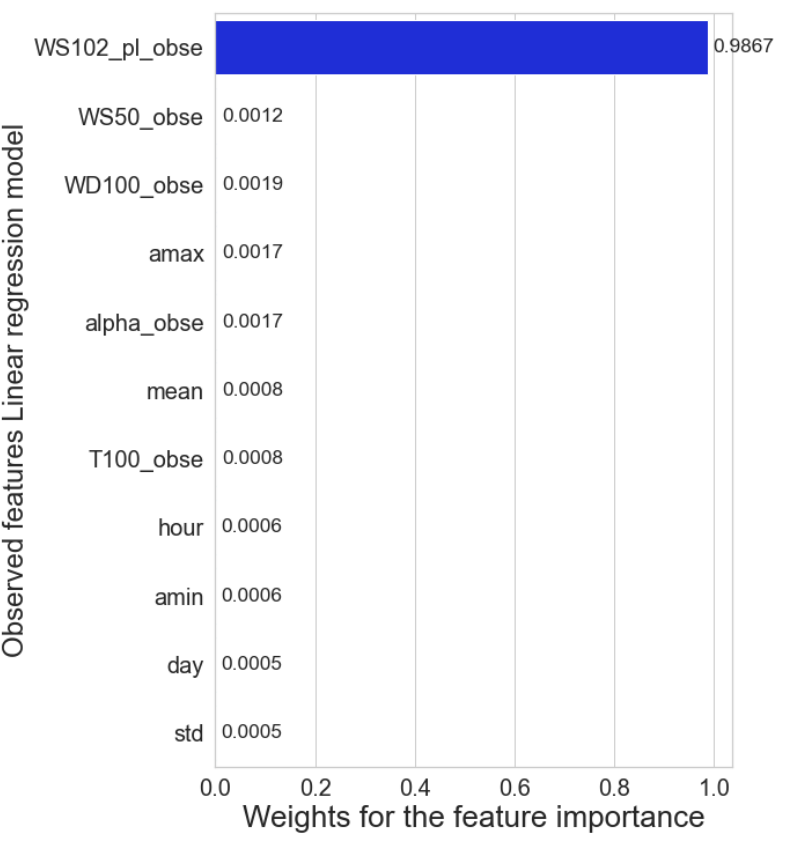
Figure 16. Feature importance for Random Forest in Scenario